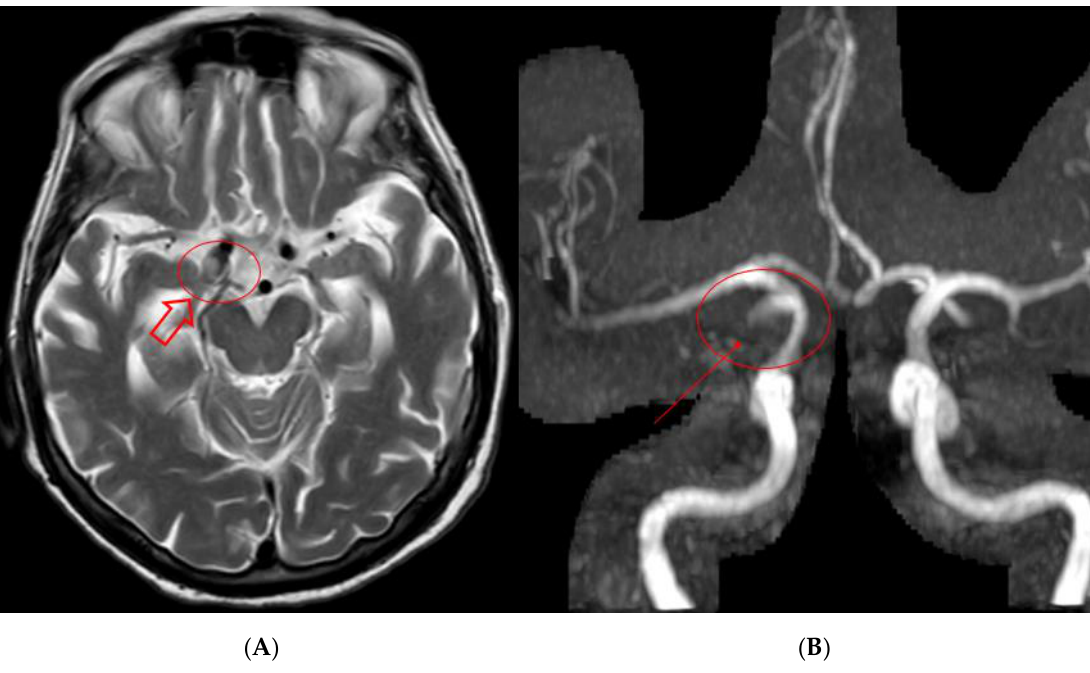
Figure 5. Findings: Six-months MR and MRA performed at our institution: ( A ) T2 brain acquisition showing shrinkage of the aneurysmatic sac on the left ICA (hollow arrow); ( B ) 3D TOF MRA acquisition showing minimal signal intensity on the neck portion of the aneurysmatic sac (solid arrow).